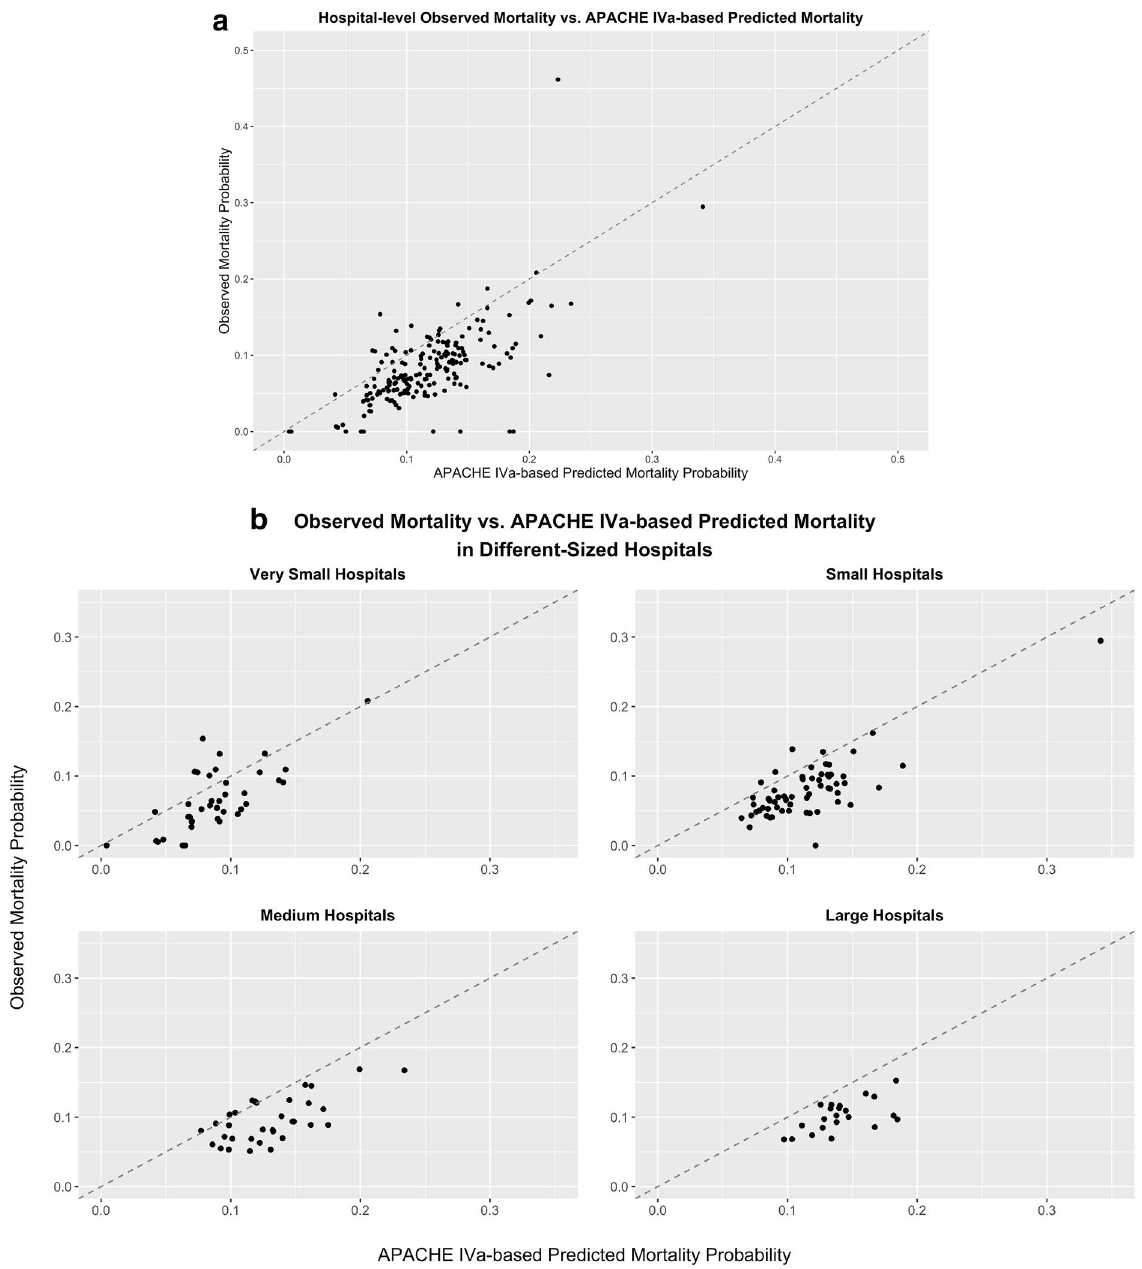
Figure 2. ( a ) Hospital-level observed mortality versus APACHE IVa-based predicted mortality. ( b ) Observed mortality versus APACHE IVa-based predicted mortality in different-sized